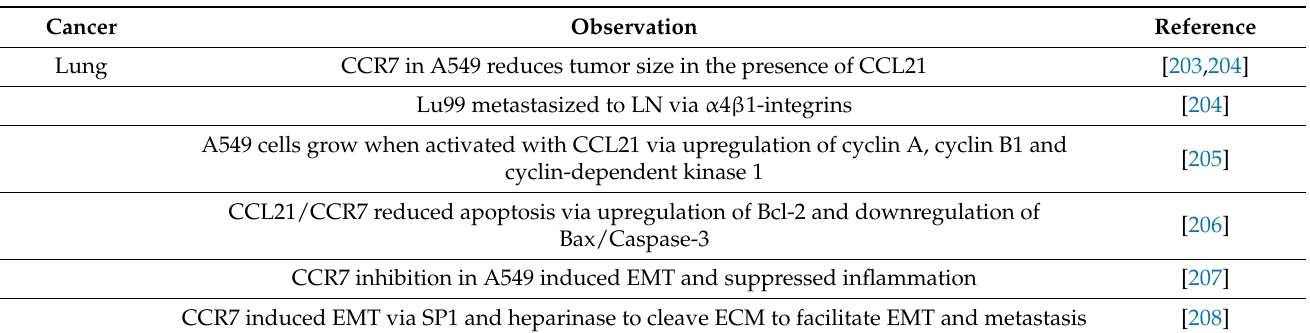
Table 5. The roles of CCR7 in epithelial